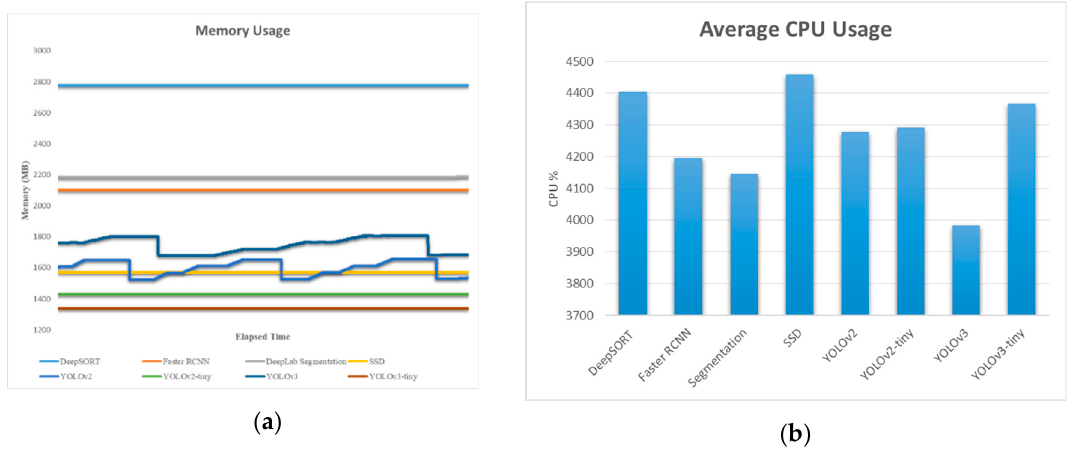
Figure 18. ( a ) Memory usage and ( b ) average CPU usage percentage in Xavier.